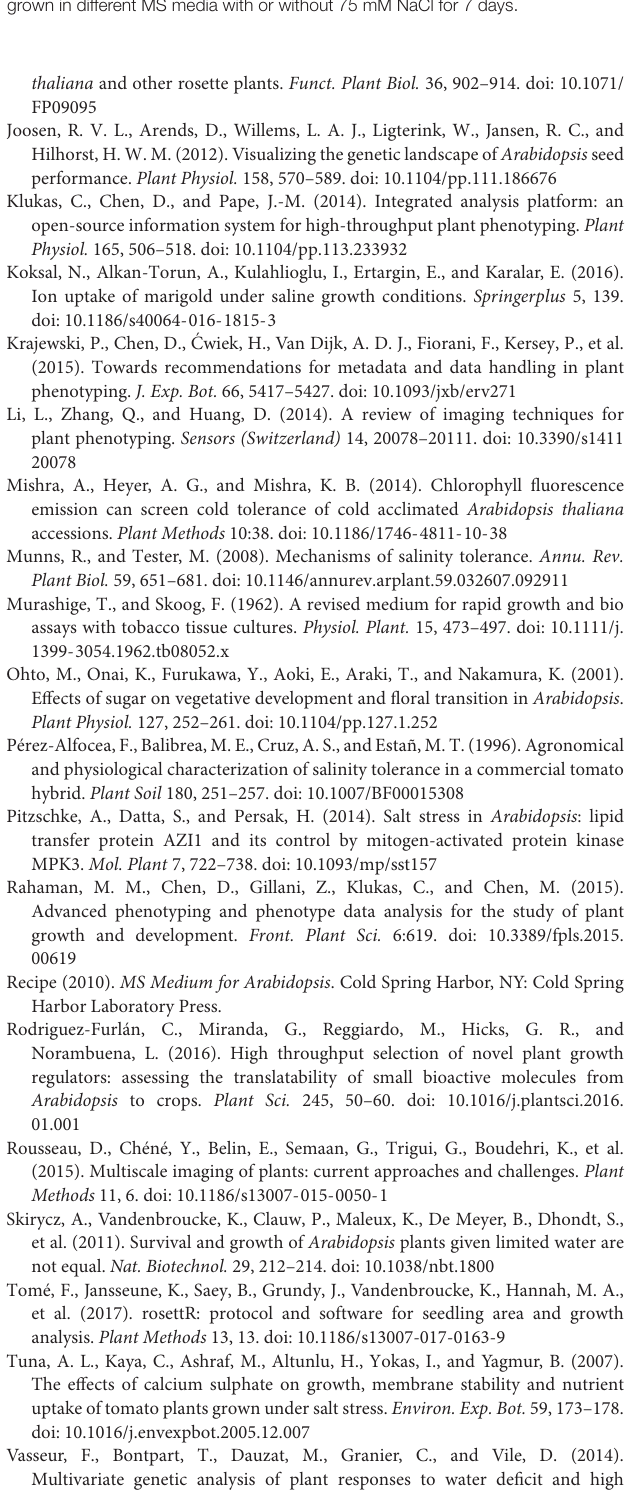
FIGURE S2 | Green area (pixels) of 4 DAG Arabidopsis seedlings grown in 12-well plates (n = 36) with 1 × MS medium with different sucrose concentrations (0, 0.1 or 1%) for 8 days. Mean ± SE. FIGURE S3 | Variation among replicates in Arabidopsis rosette growth in different MS media with salt. Box plots representing the green area (pixels) of 4 DAG